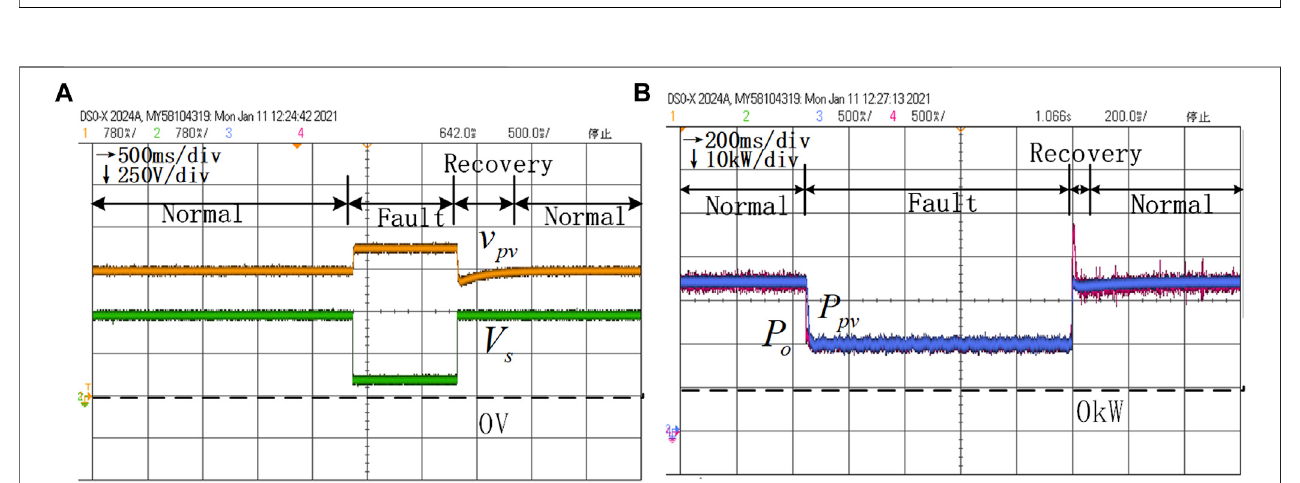
FIGURE10 | HIL results of voltage dynamicsand power dynamicswithout the variable parametercontrolunder the conditions of k p (cid:1) 0 . 1 , k i (cid:1) 5 , and C pv (cid:1) 1mF. (A) Voltage dynamics of v s and v pv . (B) Power dynamics of P o and P pv .